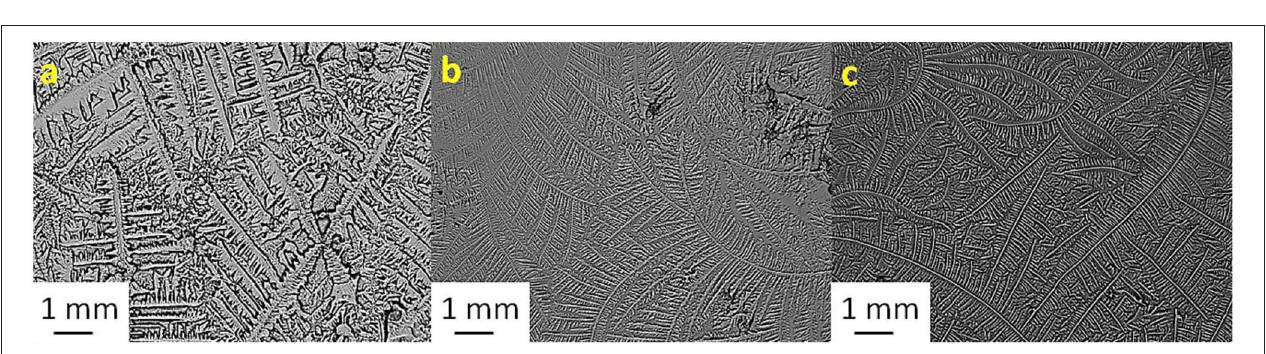
FIGURE 1 | Tear ferning patterns of (a) S1, (b) S1:KCl (1:10), and (c) S1:CaCl 2 (1:10). S1, first sheep tear sample.